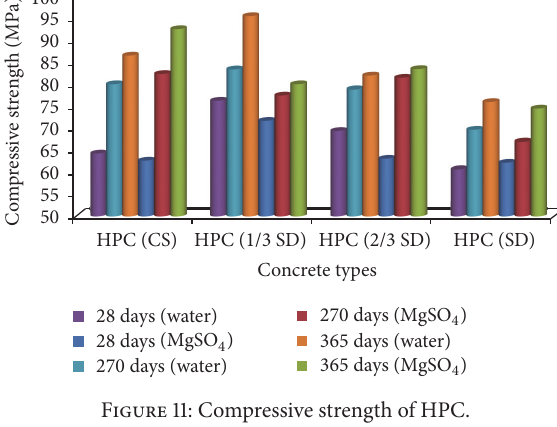
Figure 11: Compressive strength of HPC.